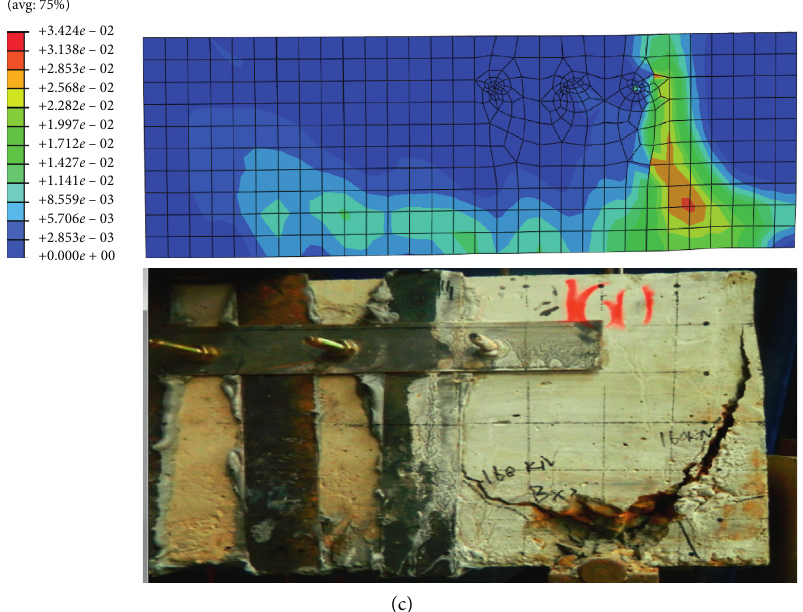
Figure 14: Maximum principal stress nephogram and crack distribution of the strengthened beams: (a) beam S10C30, (b) beam U10C30, and (c) beam SU10C30.